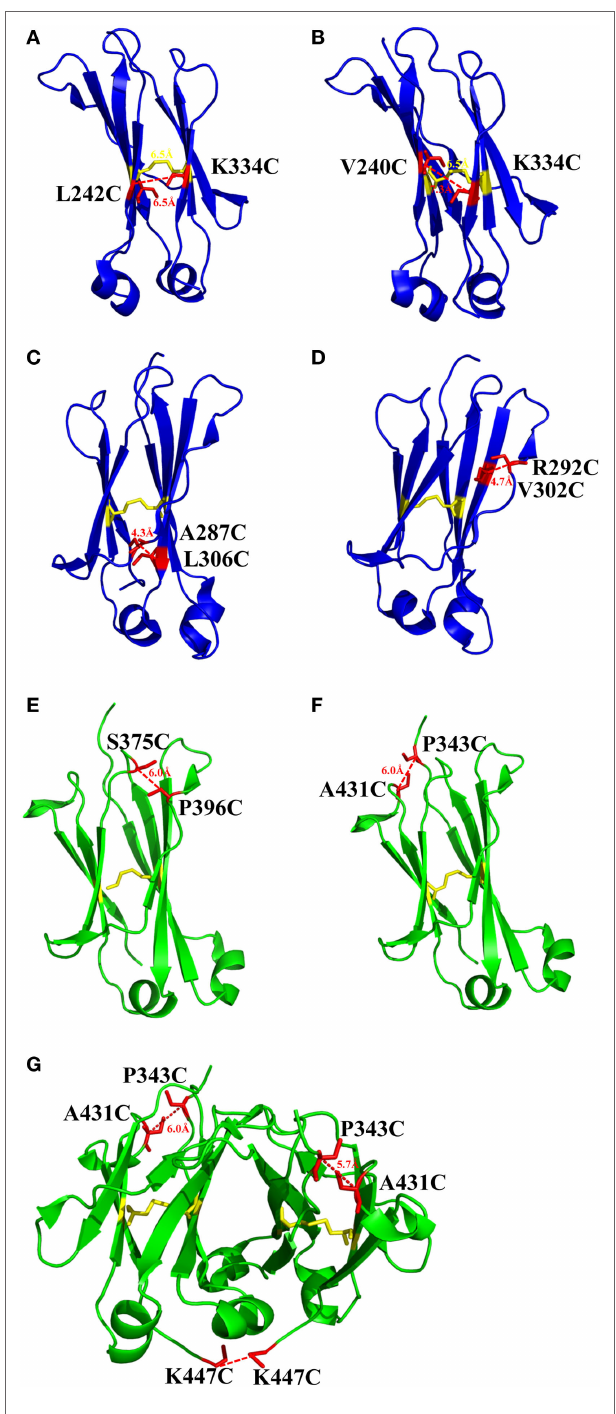
FiGURe 2 | The structures of CH2 and CH3 domains [PDB 3AVE (47)] with different mutations for introduction of additional disulfide bonds presented by PyMOL. (A) CH2 mutant L242C/K334C. (B) CH2 mutant V240C/K334C. (C) CH2 mutant A287C/L306C. (D) CH2 mutant R292C/V302C. (e) CH3 mutant S375C/P396C. (F) CH3 mutant P343C/A431C. (G) CH3 mutant P343C/A431C/K447C. The native disulfide bond is colored by yellow, whereas the mutated residues for additional disulfide bonds are colored by red. All the marked distance is the measured between two α -carbon atoms in related two cysteines after mutagenesis by using